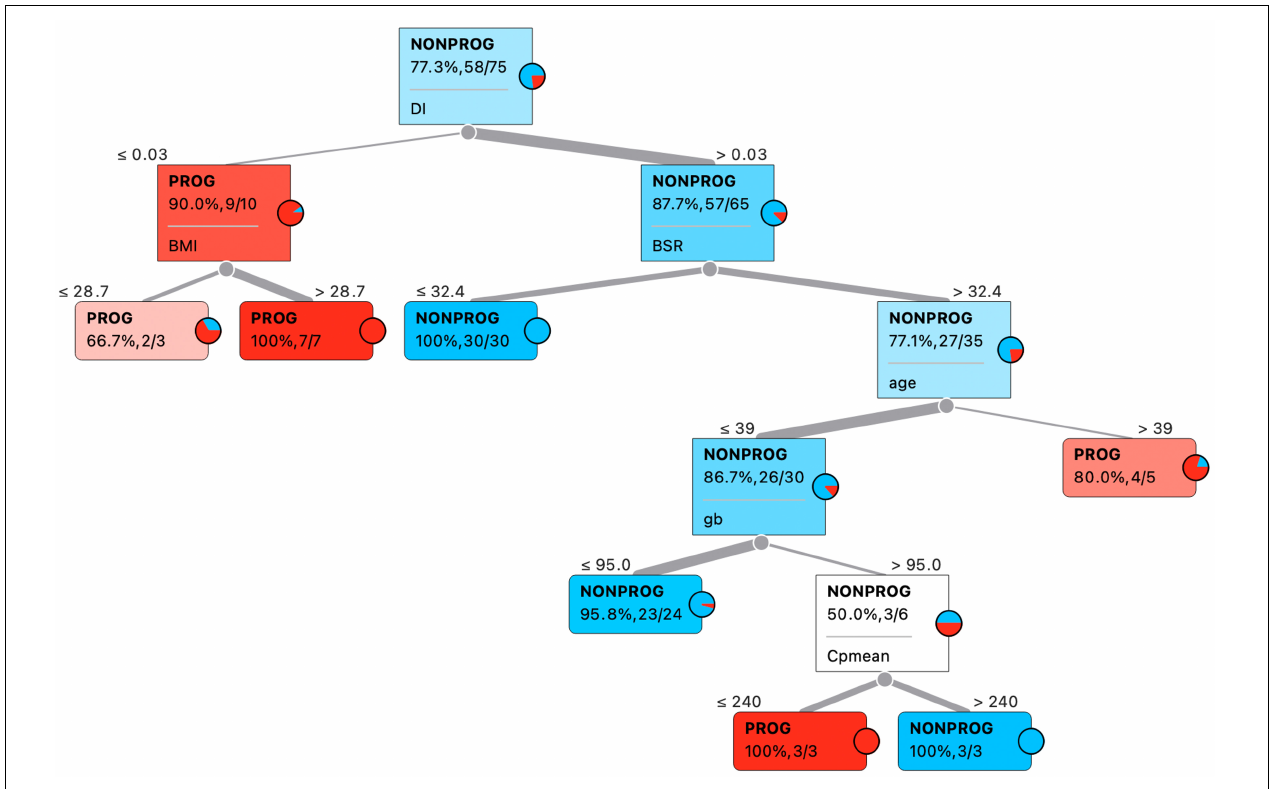
FIGURE 2 | Best predictive features according to decision tree classification algorithm.